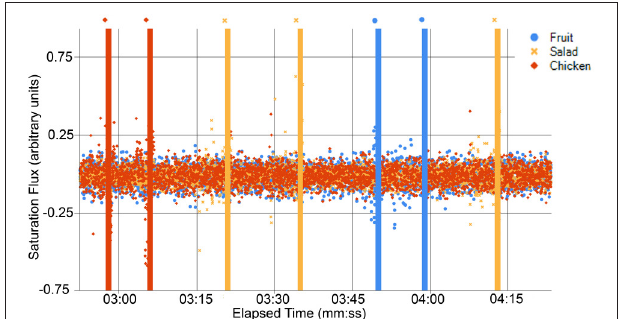
FIGURE 3 | Graph of the flux for each plate. The manually-verified time of actual bites taken are marked by the vertical lines of the same color, with a marker included below each line as well, to clarify when viewing in grayscale.